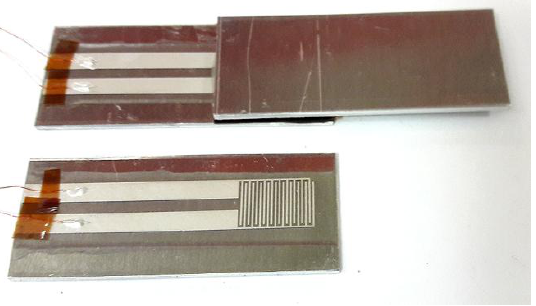
Figure 3. Screen printed sensor on metal part to be joint. The interdigital structure consist of N = 20 fingers.